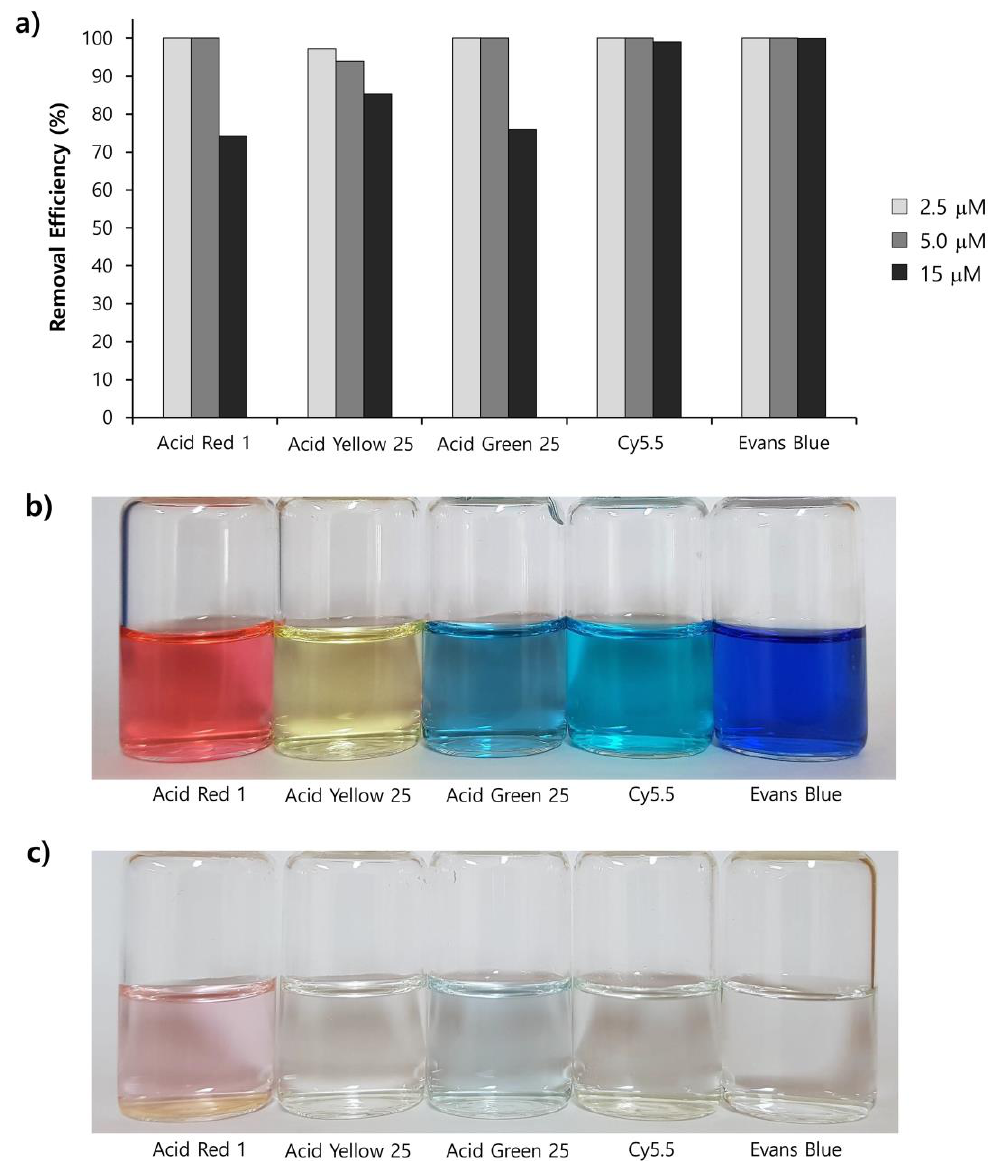
Figure 5. ( a ) Removal e ffi ciencies of anionic dyes using Fe-DC (2.5, 5.0, and 15.0 µ M initial concentration) at pH 7. Photographic images ( b ) before and ( c ) after purification of anionic dyes (15.0 µ M initial concentration).